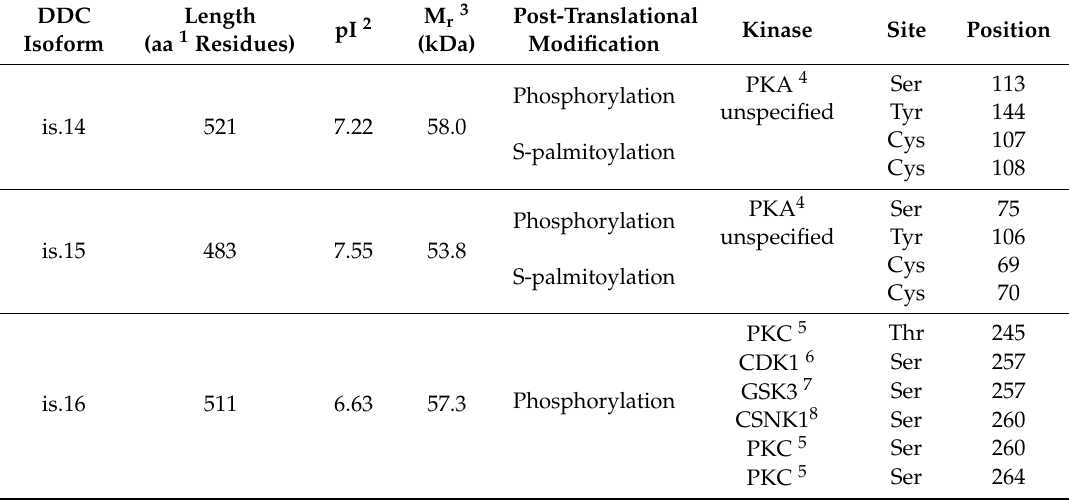
Table 1. Properties of the deduced DDC protein isoforms and putative post-translational modification sites residing in their novel peptides, based on bioinformatical